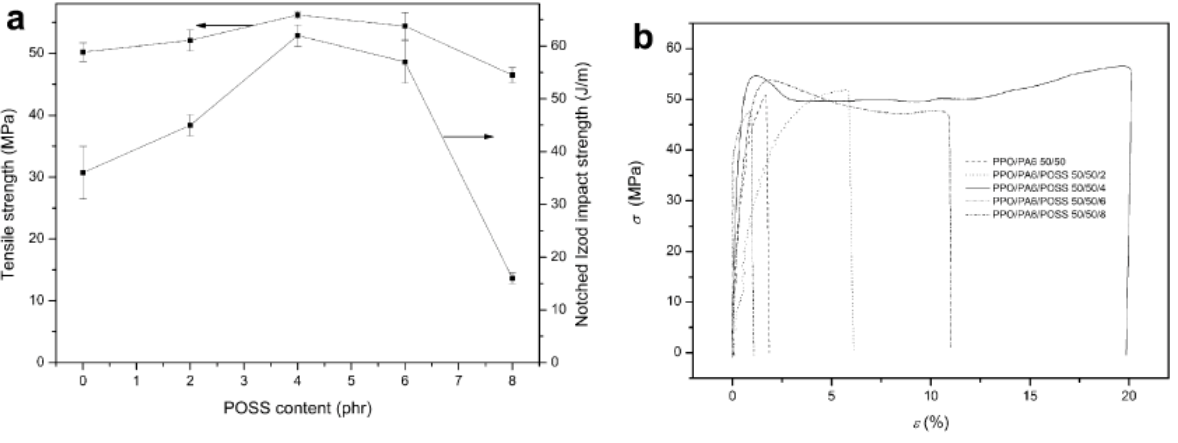
Figure 8. Effects of POSS on: ( a ) the tensile strength and the notched Izod impact strength; ( b ) Stress (r)–strain (e) curves of PdMPO/PA6/POSS nanocomposites. Reproduced with permission from Li et al . [67]. Copyright 2009,